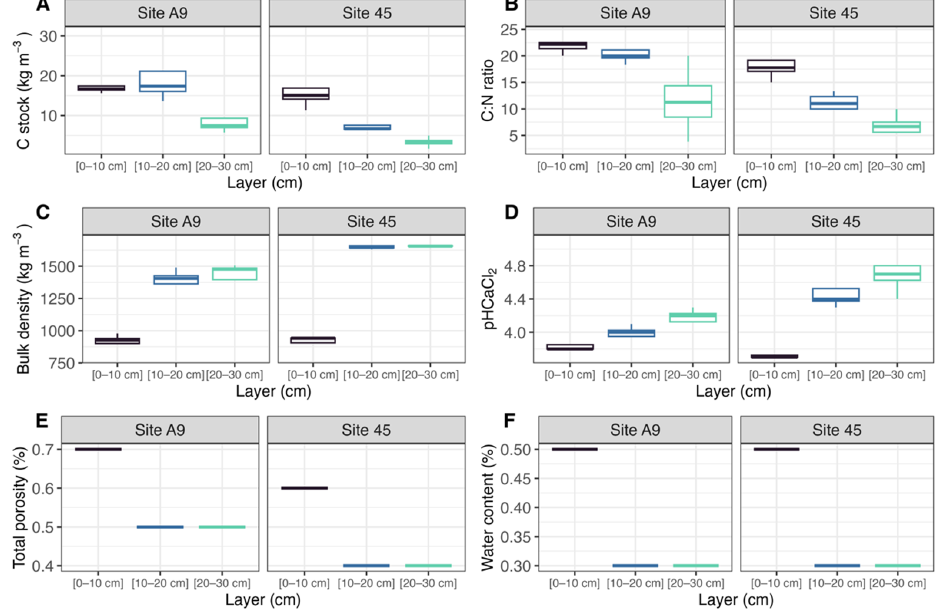
Figure 1. Soil properties in layers of cranberry soils: ( A ) C stock, ( B ) C:N ratio, ( C ) bulk density, ( D ) pH CaCl , ( E ) total porosity (volumetric fraction), ( F ) water content (volumetric 2